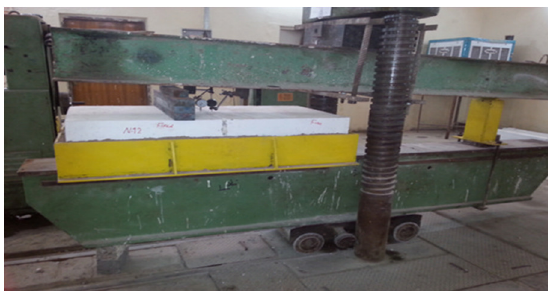
Fig. 4. Test of the Specimen on Subgrade